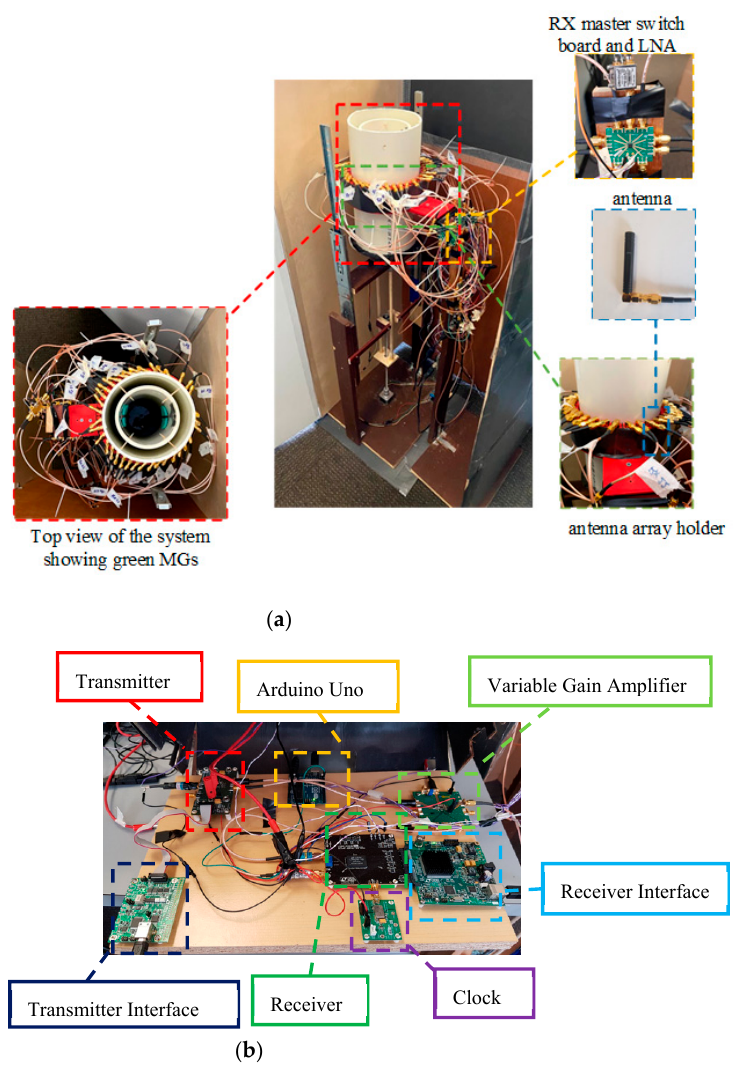
Figure 11. ( a ) Picture of the main components for the imaging system and ( b ) data acquisition circuitry. Here, two PVC pipes contain a liquid mixture of 60% water and 40% glycerin with relative permittivity of 62 and conductivity of 2.15 S/m at the operating frequency band [30]. The outer pipe has an inner diameter of 152 mm (6 in), a thickness of 5 mm, and a height of 300 mm. The inner pipe has an inner diameter of 101.6 mm (4 in), a thickness of 7 mm, and